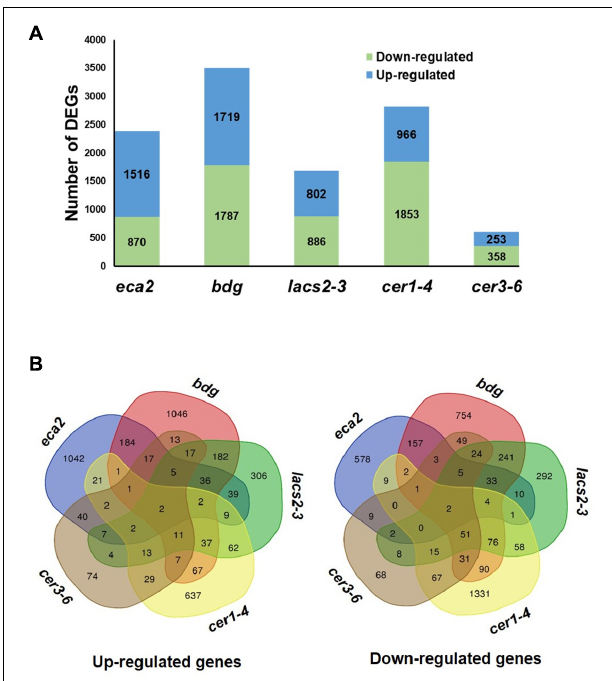
FIGURE 4 | Transcriptome analysis of non-infected cuticular mutants. (A) Number of differentially expressed genes (DEGs) (Log2FC ≥ 1 or ≤ –1 with an adjusted p -value ≤ 0.05) identified in the cutin and wax mutants. (B) Venn diagrams show the overlap of upregulated and downregulated genes among the cutin or wax